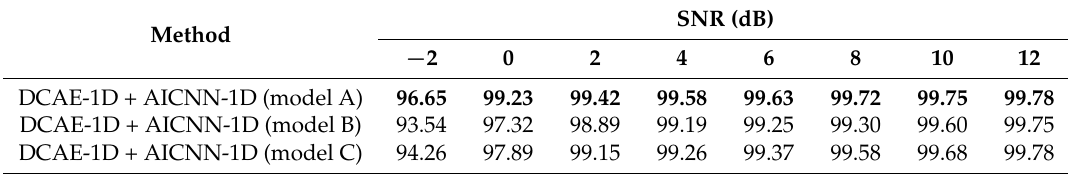
Table 8. Reconstruction errors of DCAE-1D with different depth.